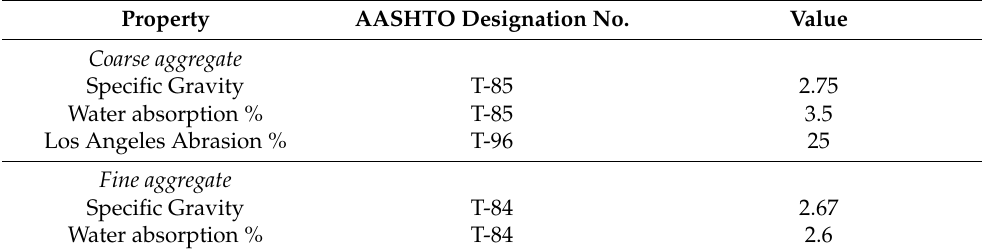
Table 1. Aggregate properties.